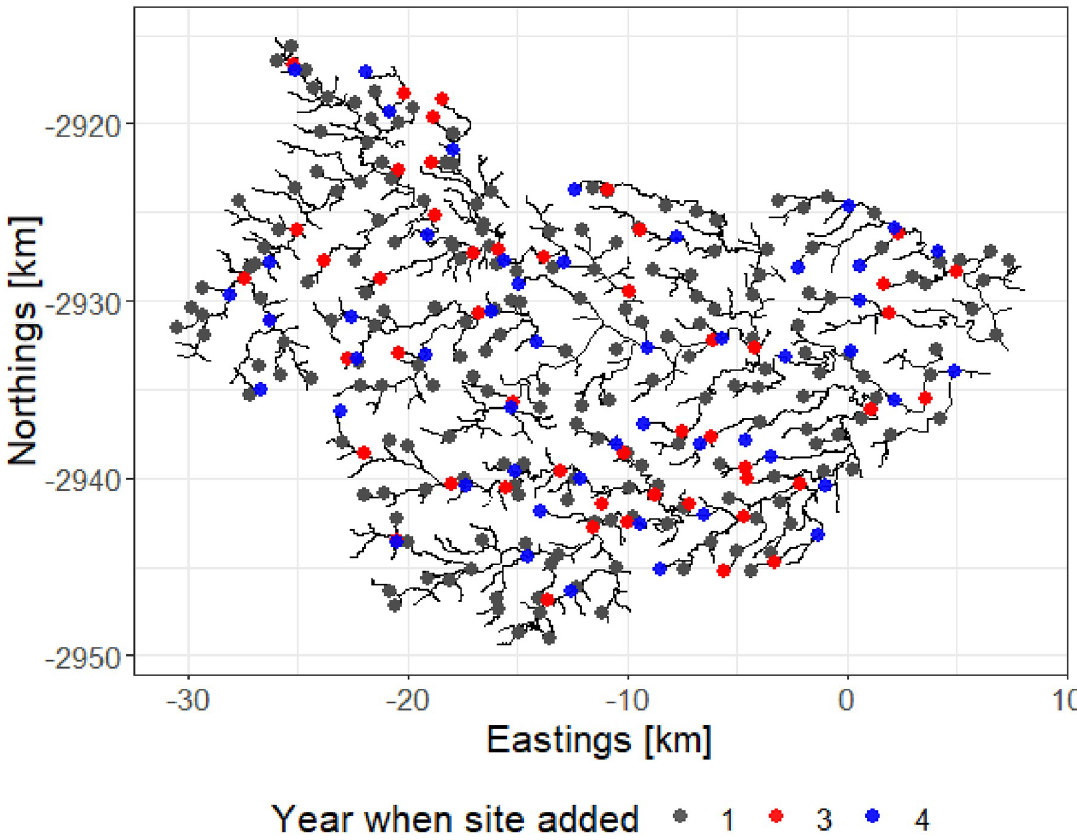
Fig 6. The Pine River stream network. The sites on the network represent the evolution of the adaptive design through time.